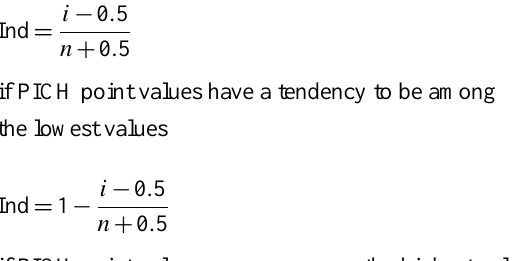
Figure 4. Illustration of the separation of a data set into four classes based on a combination of two factors, the coverage of the classes 1 to 4 appear in grey gradation: a) Thresholds limiting the classes equal to a linear combination of factors and b) combination of thresholds with connectors “and” (classes 1,2 and 4) and “or” (class 3).